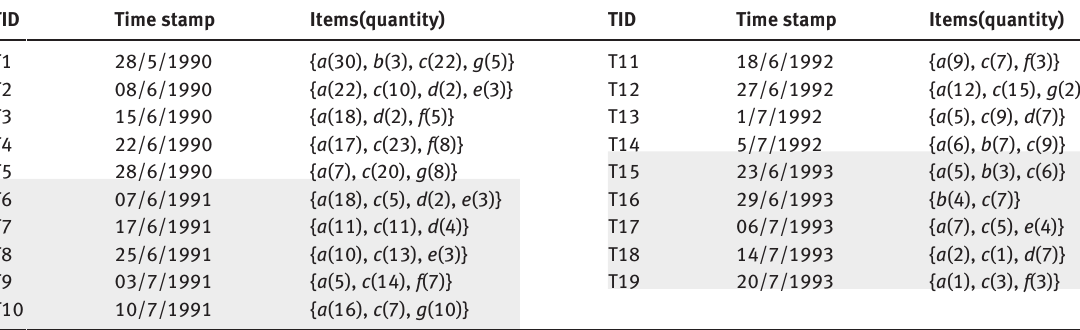
Table 1. A Sample TIMT -Type Database